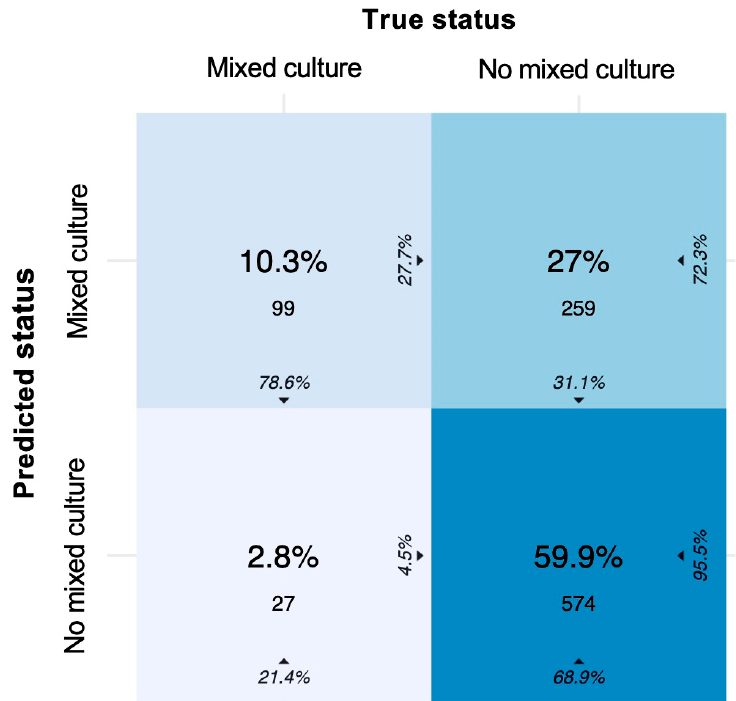
Figure 5. Confusion matrix of the two-class approach to predict mixed culture. Colour intensity represents the overall percentages in the middle of each tile. The column percentage is shown at the bottom, and the row percentage can be seen 90 degrees rotated to the right of each tile. In the diagonal from top left to bottom right, the column percentages represent the SE, and the row percentages represent the PPV of each class, e.g., in the upper left quadrant, 10.3% ( n = 99) of all observations was predicted as mixed culture, where the true status was mixed culture. This corresponds to 78.8% of all true mixed cultures and 27.7% of all predicted mixed cultures.